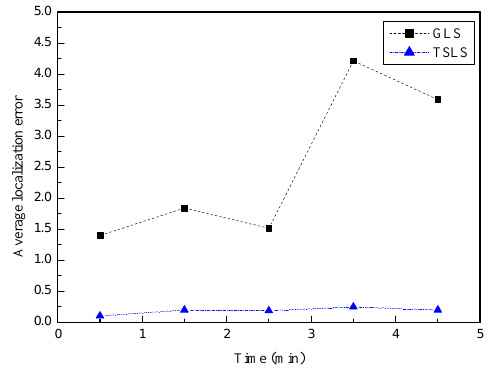
Fig.9. Average localization error of unknown nodes when removing beacon nodes from the